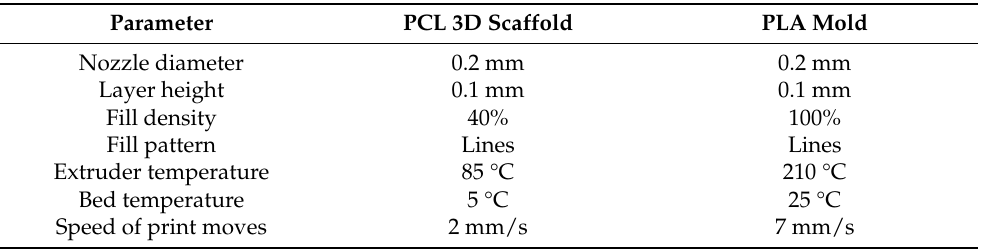
Table 1. Printer settings employed for polycaprolactone (PCL) 3D scaffold and polylactic acid (PLA)